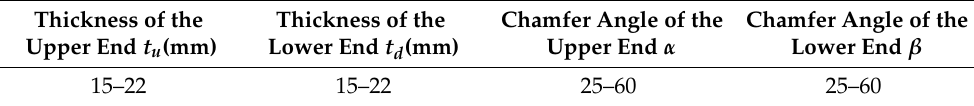
Table 3. Value interval of structural parameters of the rubber